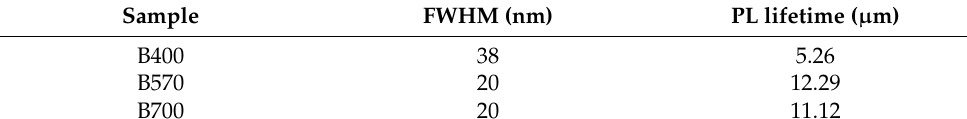
Figure 3. PL spectra of upper layer prepared at different substrate temperatures. Table 3. FWHM and PL lifetime for film fabricated at different substrate temperatures.